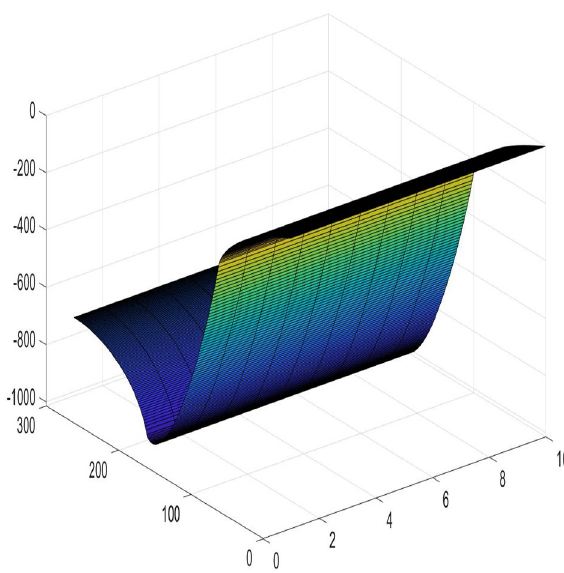
Figure 11. A 3D graph for the changes of U 300